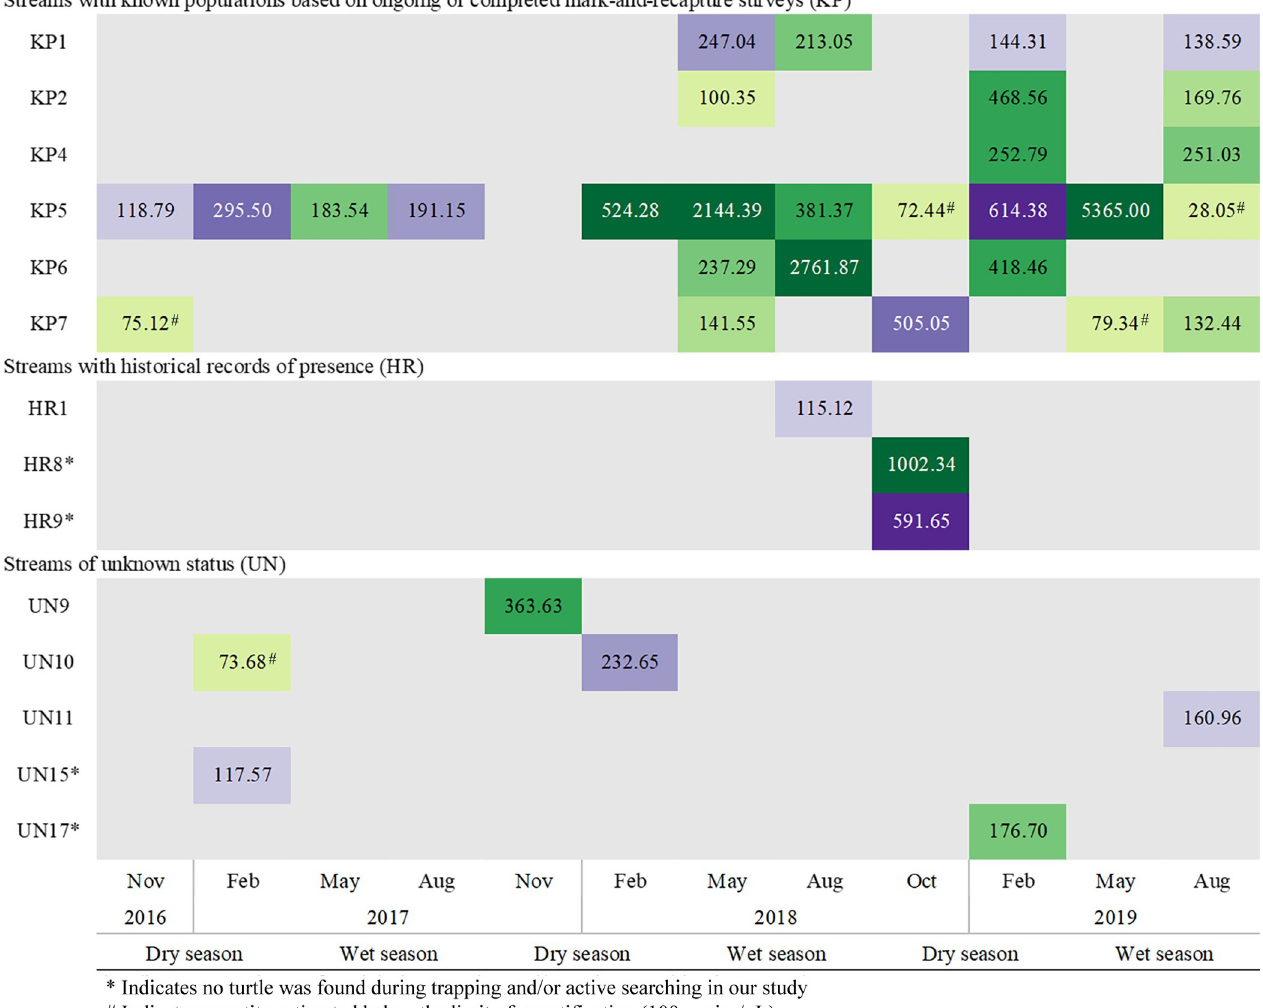
Fig 2. Heat map illustrating the concentration of eDNA detected in water samples from November 2016 to August 2019. Each depth of color indicates a percentile of concentration level (interval = 0.2). A darker color represents a higher concentration level for positive detection (in green) and uncertain detection (in purple). Grey represents samples with no amplification, and categorized as negative